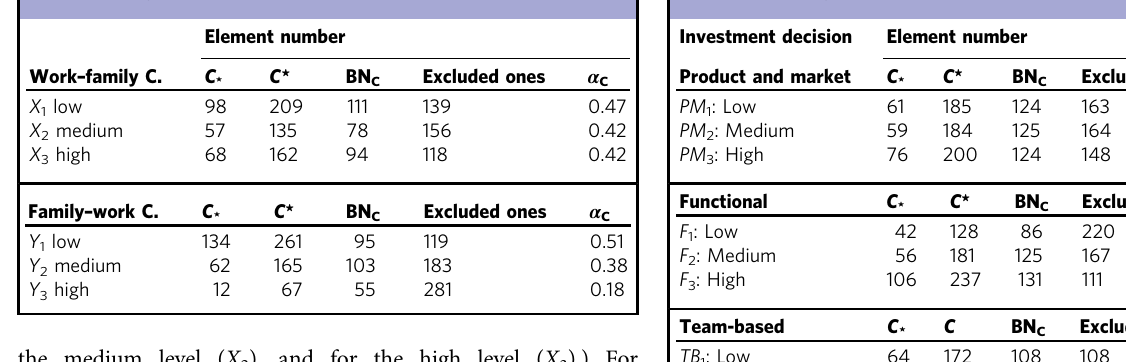
Table 4 Lower/upper approximations and boundary sets